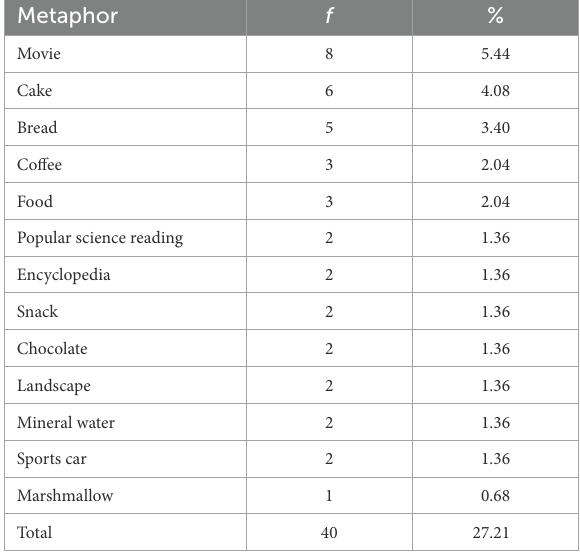
TABLE 1 Frequency and percentage of the textbook metaphor in the conceptual category of “joy/enjoyment.”